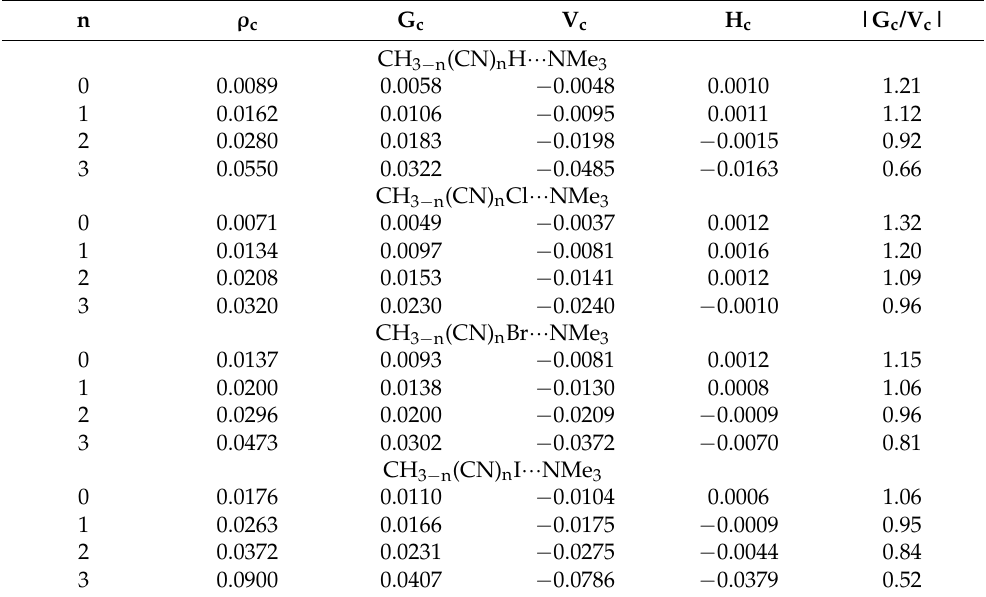
Table 8. MP2//wB97X-D/aug-cc-pVTZ topological parameters (a.u.) for CH 3 − n (CN) n X ··· NMe 3 (X = H, Cl, Br, I).